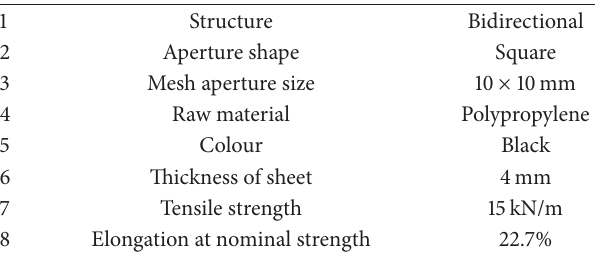
Table 1: Properties of